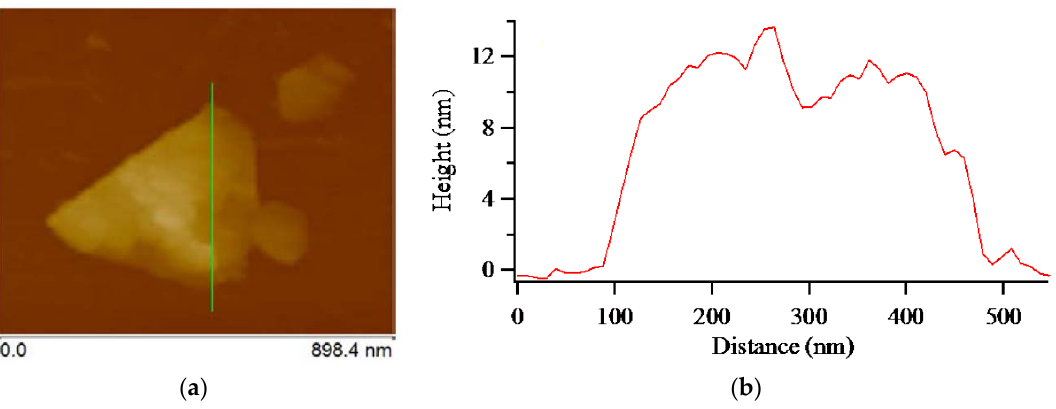
Figure 6. ( a ) Atomic force microscopy (AFM) image of the multilayer graphene (MLG); ( b ) Corresponding height profile of the